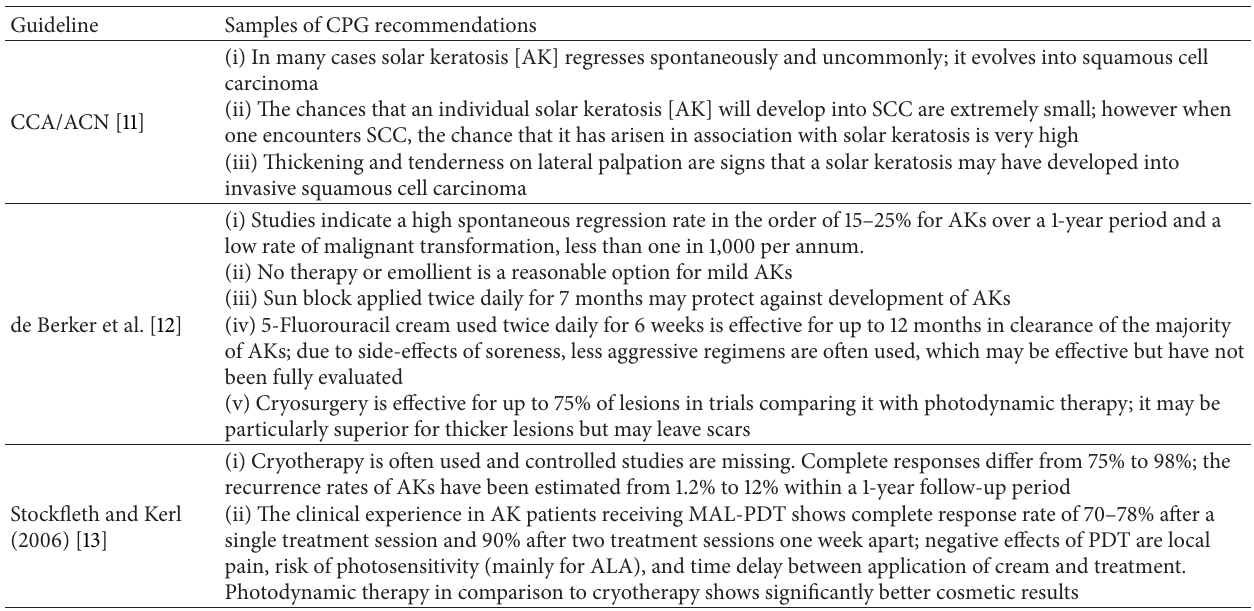
Table 3: Samples of recommendations from the three CPG with the highest overall